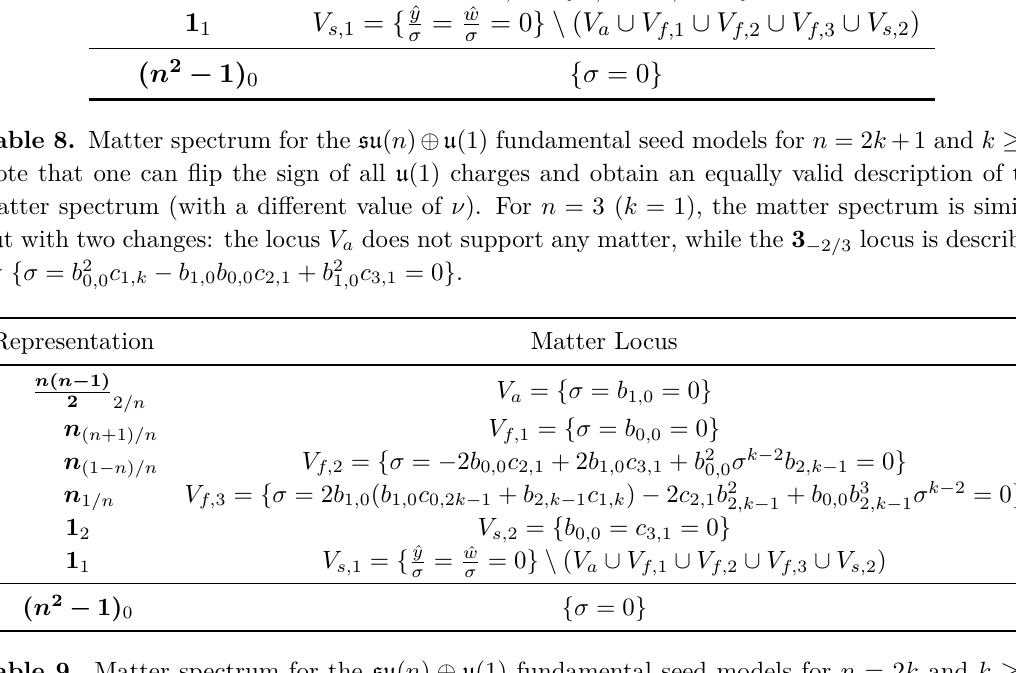
Table 9. Matter spectrum for the su ( n ) ⊕ u (1) fundamental seed models for n = 2 k and k ≥ 2 . Note that one can flip the sign of all u (1) charges and obtain an equally valid description of the matter spectrum (with a different value of ν